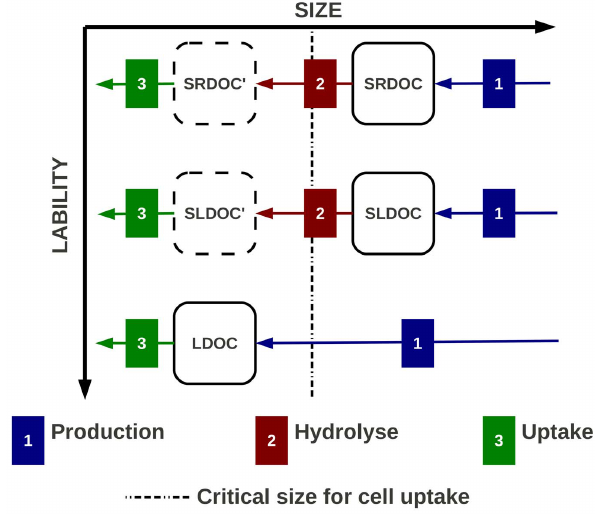
Fig. 2. Diagram representing dissolved organic matter in the model. Each pool is discriminated based on size and lability assumptions. Two pools (SLDOC and SRDOC) are considered similar in size and above the critical size of particle that can pass through bacterial cell wall (thus they need an hydrolysis step before being assimilated). LDOC on the other hand is considered to be directly assimilable. In terms of lability, each DOC pool is associated with an assimila- tion efficiency of 0.7, 0.5 and 0.3 for LDOC, SLDOC and SRDOC